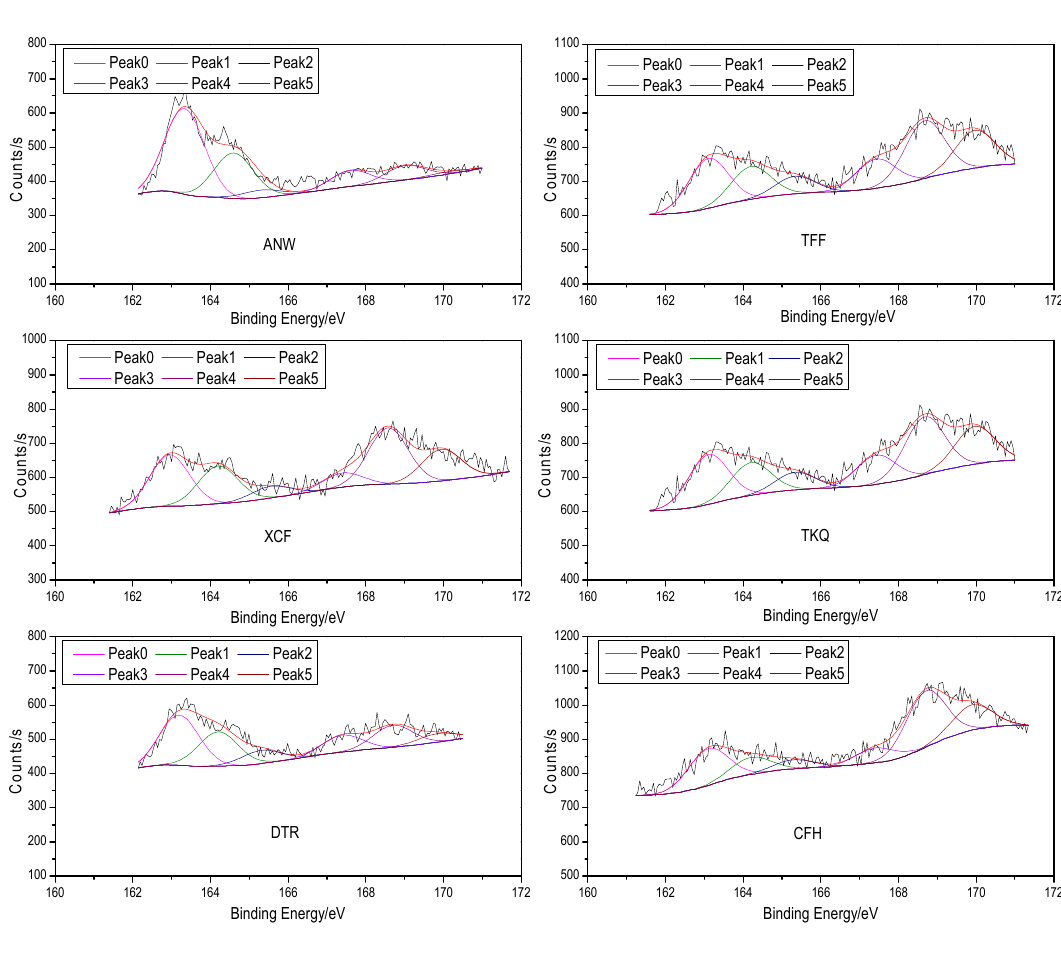
Table 1. The XPS S 2p analysis of six raw coal samples. Sample